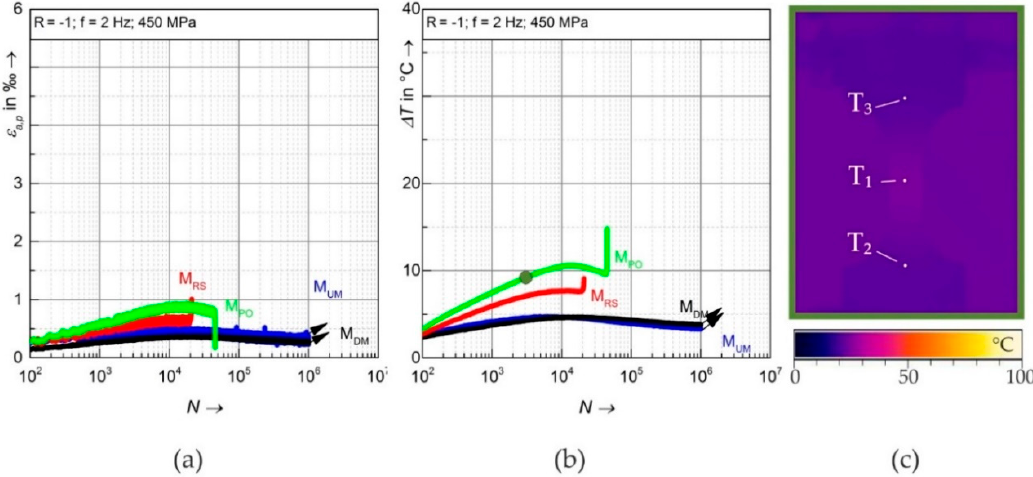
Figure 10. Stress-controlled single step tests at 450 MPa, f = 2 Hz: ( a ) development of plastic strain amplitude ( ε a,p ) vs number of cycles ( N ); ( b ) development of temperature change ( Δ T ) vs number of cycles ( N ); ( c ) distribution of temperature on a specimen with morphology M PO at N = 3000.